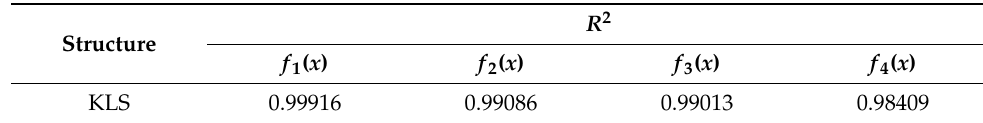
Table 3. Fitting accuracy of approximate models of